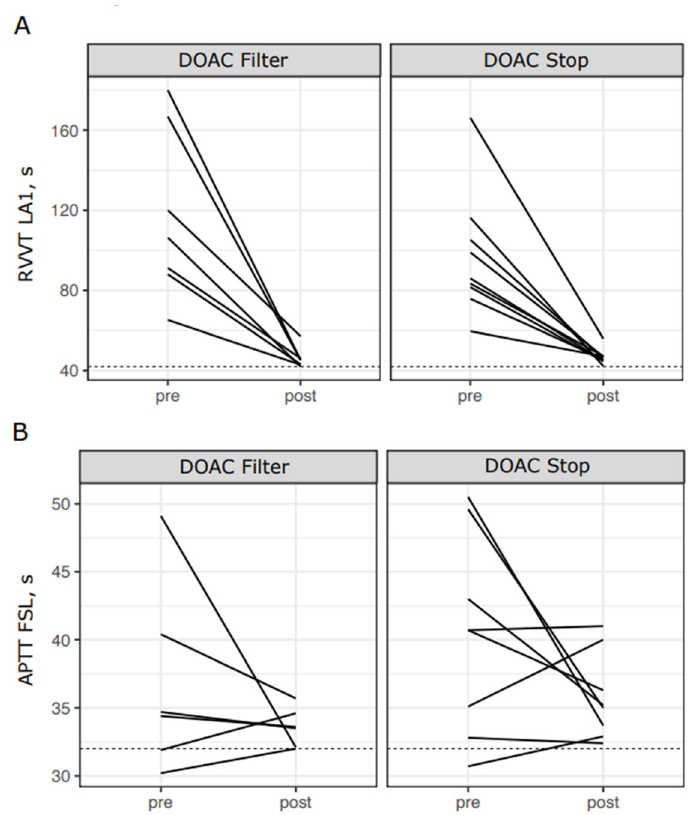
Figure 5. DOAC removal methods reduce clotting times even though the screening test results remain positive. The figure shows results for samples in which the RVVT screening test results (( A ), LA1) or APTT-based screening test (( B ), APTT.FSL) remained positive even after DOAC removal by DOAC Filter ® or DOAC-Stop™. The median difference for LA1 was − 63 s for DOAC Filter ® - treated samples ( p = 0.016) and − 41 s for DOAC-Stop™-treated samples ( p = 0.0039). The median difference for APTT.FSL was − 1.0 for DOAC Filter ® -treated samples ( p = 0.69) and − 2.4 for DOAC- Stop-treated samples ( p = 0.73). Abbreviations: pre, before DOAC removal; post, after DOAC removal.